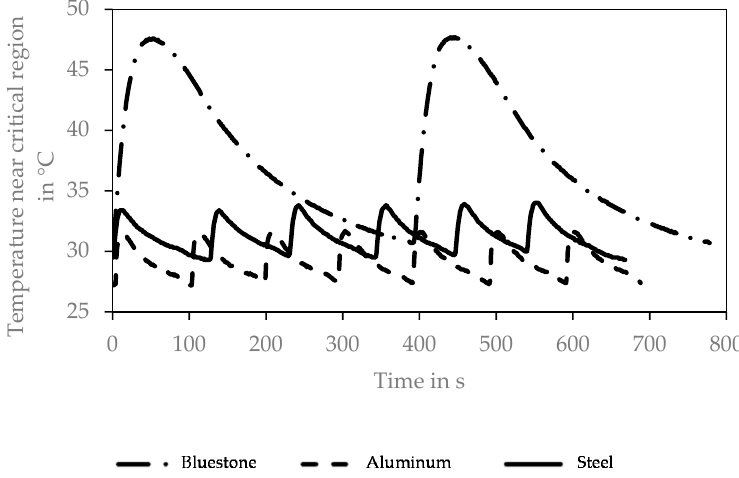
Figure 12. Recorded temperatures near critical region of cavity within Bluestone, aluminum, and steel tools for tensile specimens.